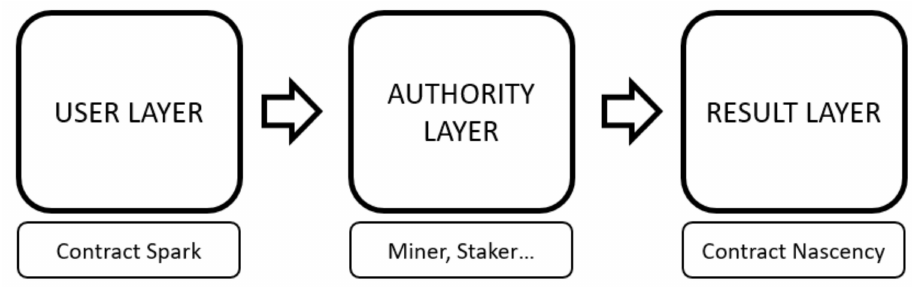
Figure 8. Blockchain layer-based process